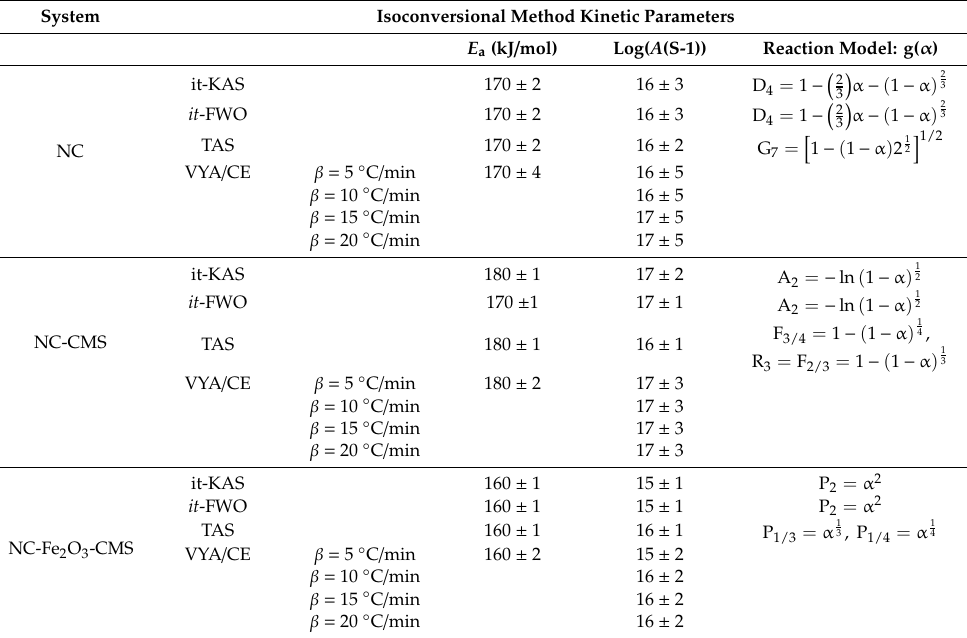
Table 2. The kinetic parameters of the investigated samples.